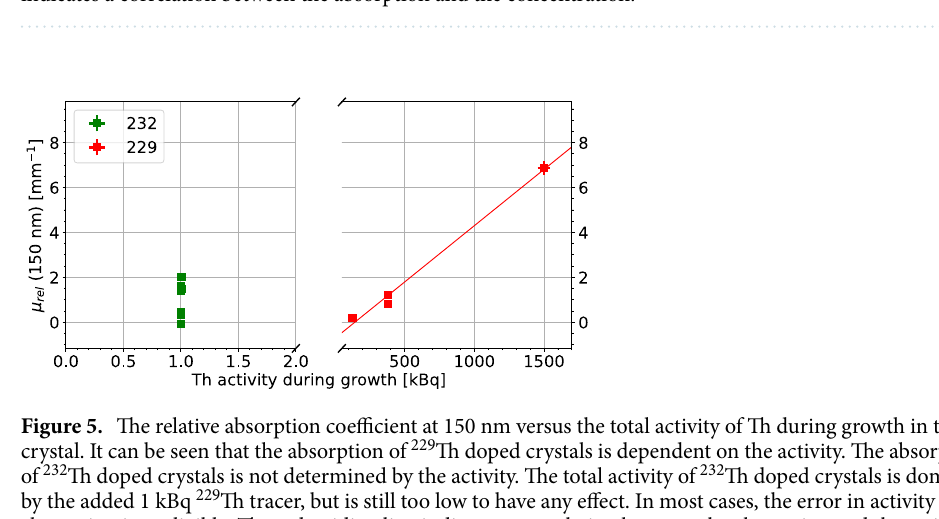
Figure 4. The relative absorption coefficient at 150 nm versus the concentration of Th in the crystal. It can be 232 seen that the absorption of Th doped crystals is dependent on the concentration. The absorption of doped crystals is not determined by the concentration of Th due to its low concentration. The highest reached 229 Th doping concentration was 5.0 × 10 18 cm − 3 , however this crystal was completely opaque thus was not included. In most cases, the error in both concentration and absorption is negligible. The green guiding line indicates a correlation between the absorption and the concentration.